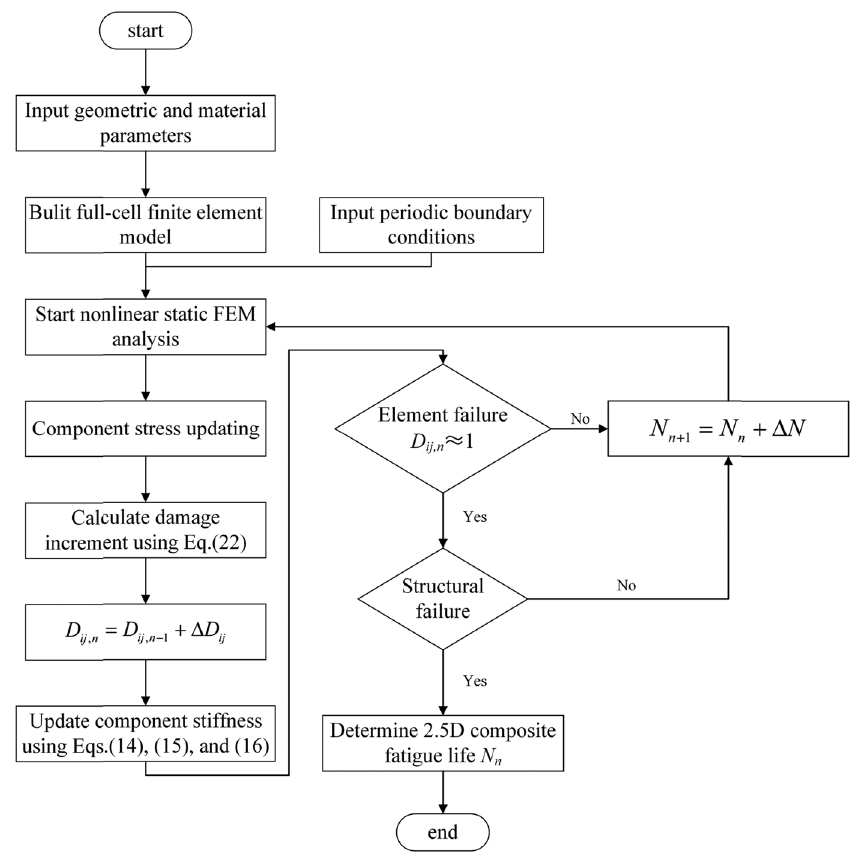
Figure 9: Flowchart for the fatigue life prediction of 2.5D woven composites.